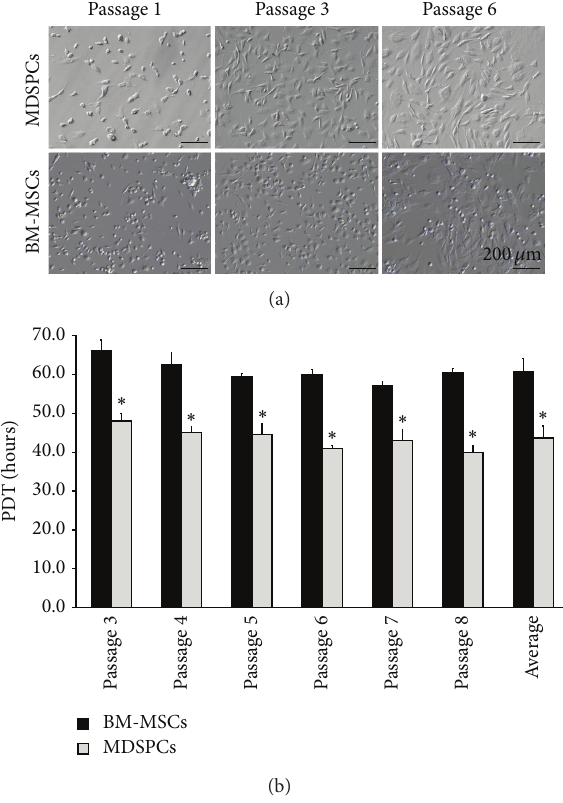
Figure 2: Morphology and proliferation analysis of MDSPCs and BM-MSCs. (a) The BM-MSCs during the first day of culture appeared as round-shaped cells. After 3-4 days, the adherent cells became spindle-shaped (BM-MSCs, passage 1). BM-MSCs were passaged after reaching 65–70% confluence (BM-MSCs, passages 3, 6). MDSPCs appeared as round, triangular, or spindle-shaped (MDSPCs, passage 1). MDSPCs were passaged after reaching 65– 70% confluence (MDSPCs, passages 3, 6). (b) MDSPCs had sig- nificantly higher proliferation rate ( 𝑝 < 0.05 ) in comparison to BM-MSCs, as reflected by the average population doubling time. The average PDT of MDSPCs was 43.64 ± 3.10 hours, while BM- MSCs exhibited a PDT of 60.78 ± 3.34 hours. ∗ 𝑝 < 0.05 , significant